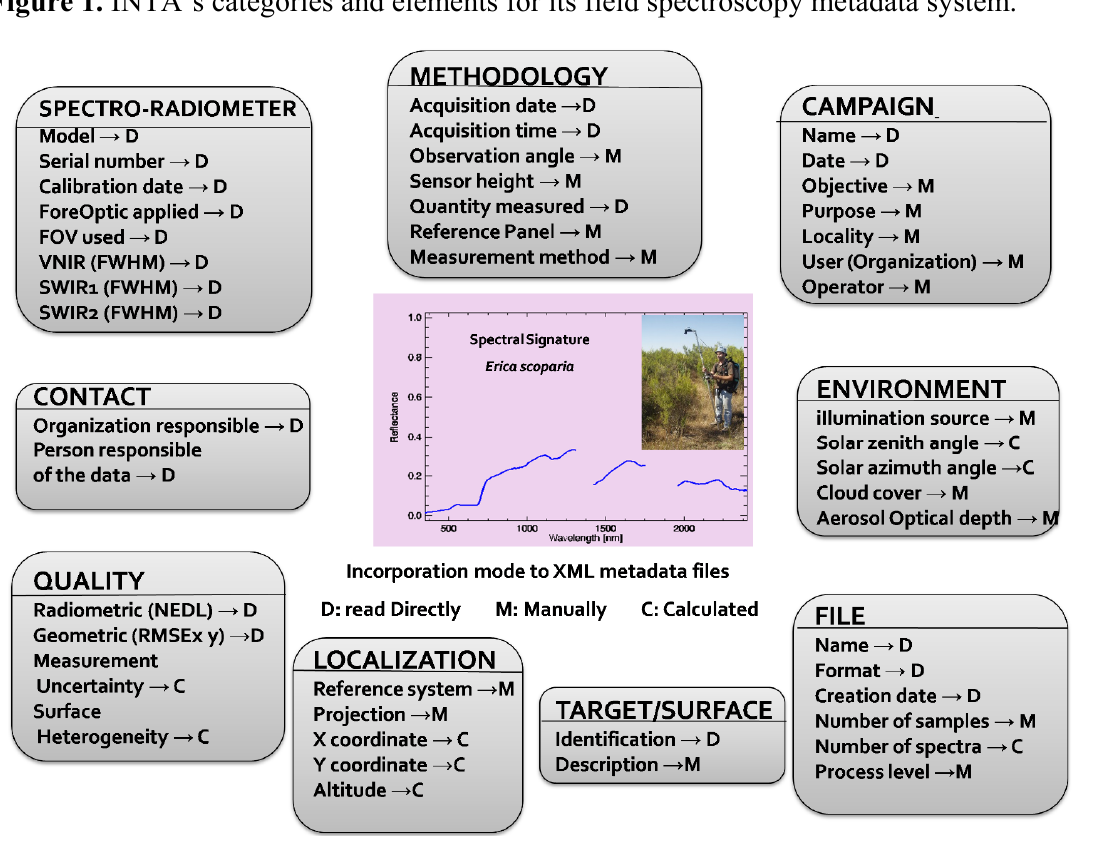
Figure 1. INTA’s categories and elements for its field spectroscopy metadata